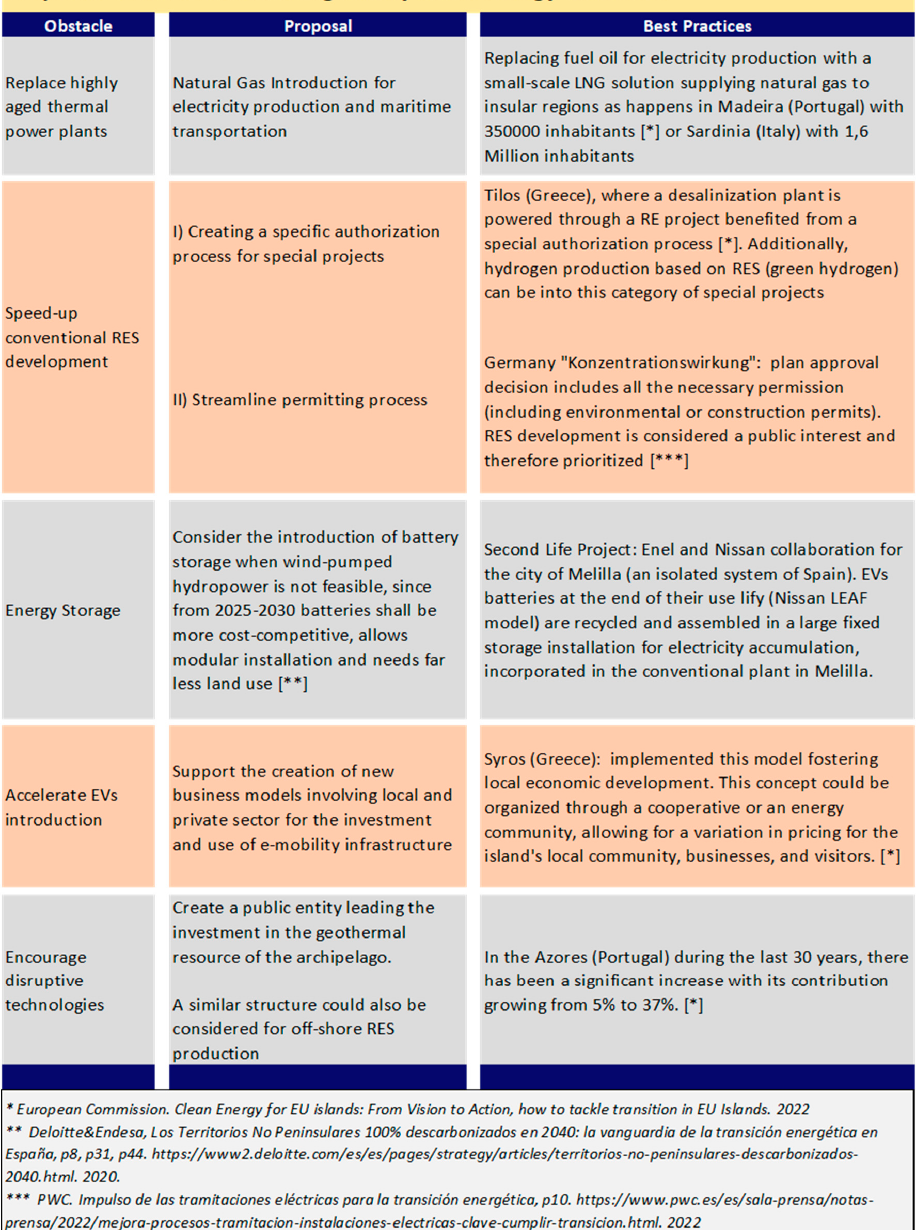
Figure 12. Scheme with main proposals and best practices.